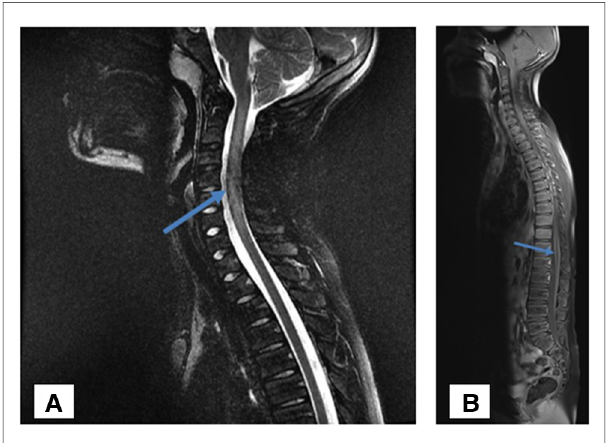
FIGURE 1 MRI of the cervical spine showing extensive centromedullary T2 weighted image (WI) hypersignal ( A ) with normal T1 WI signal impairment between the C1 – C7 metamers associated with mild swelling at the cervical spinal cord and leptomeningeal enhancement at the lumbosacral level and the cauda equine ( B